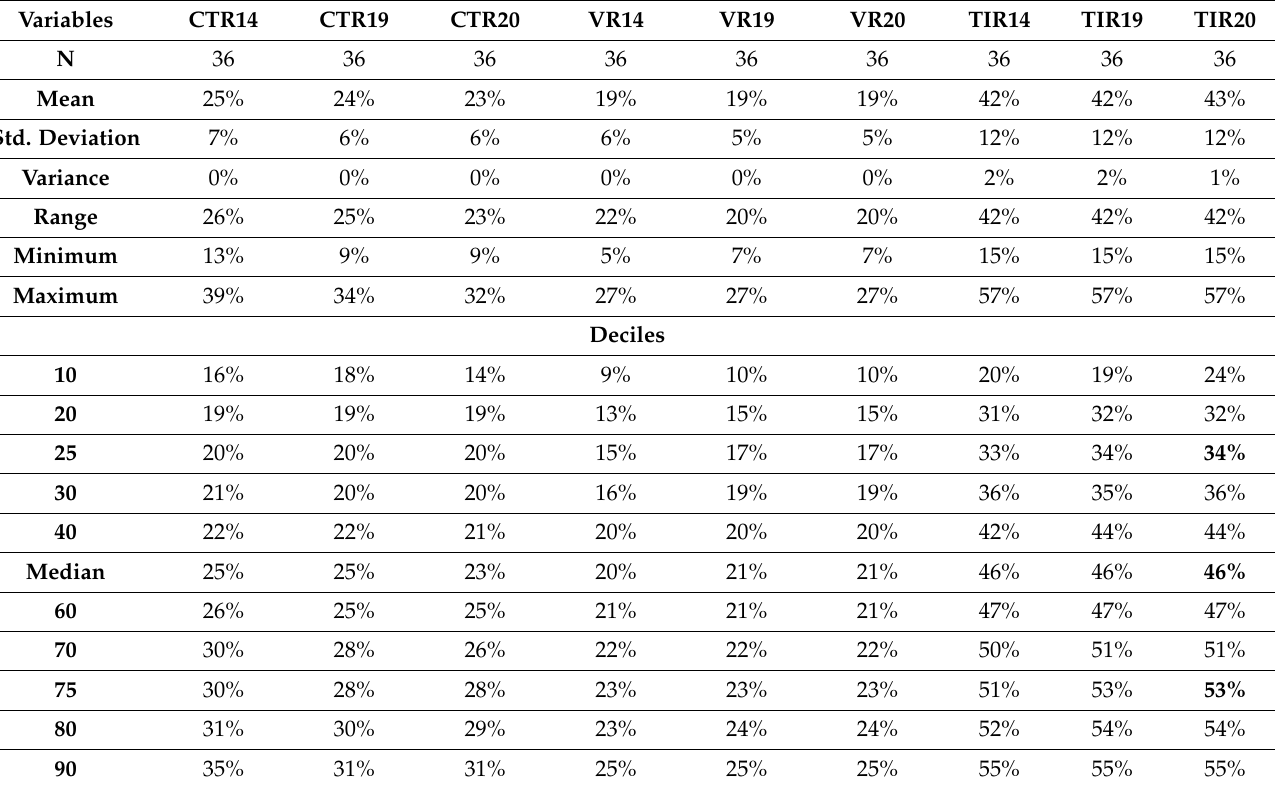
Table 4. Descriptive statistical analysis of the variables used for the composite indicator